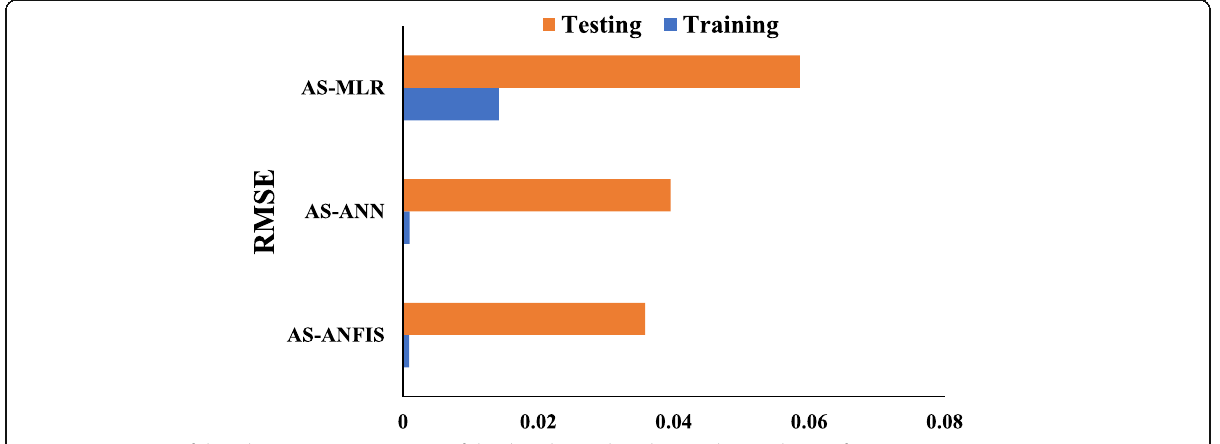
Fig. 7 Comparison of the relative mean square error of the data-driven algorithms in the simulation of AS